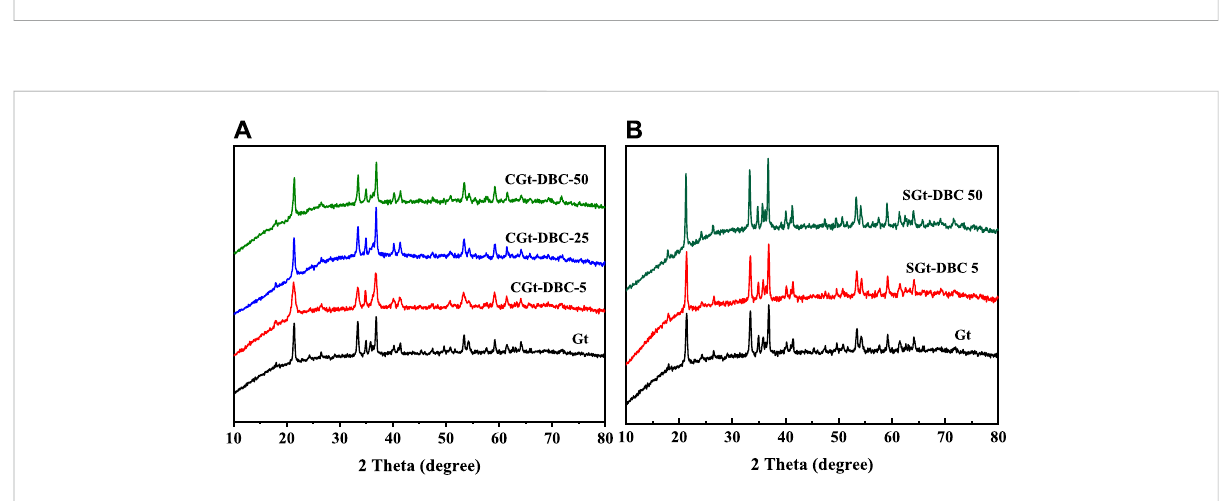
FIGURE 2 XRD patterns of Gt and Gt-DBC samples (CGt-DBC, the coprecipitated Gt-DBC complexes; SGt-DBC, the adsorbed Gt-DBC complexes; Numbers indicate the additive concentration of DBC in the preparation of Gt-DBC